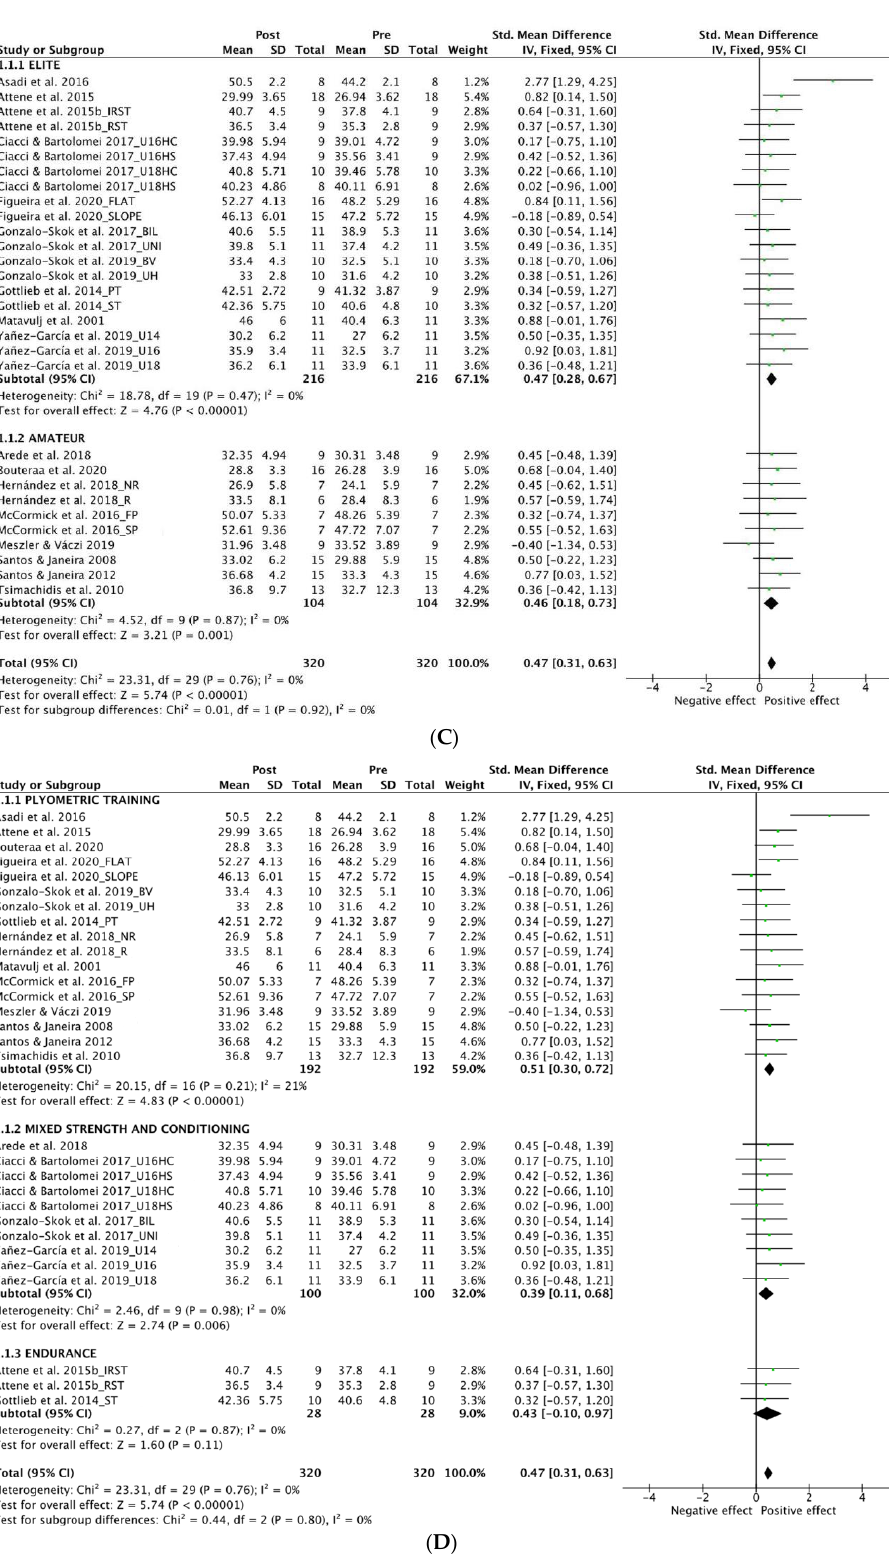
Figure 4. Forest Plot comparing the effect of multidisciplinary interventions on neuromuscular power vertical (NPV) considering sub-groups analysis for age ( A ), gender ( B ), level ( C ) and type of intervention ( D ) [49,50,52,62 – 64,66 – 68,70 –